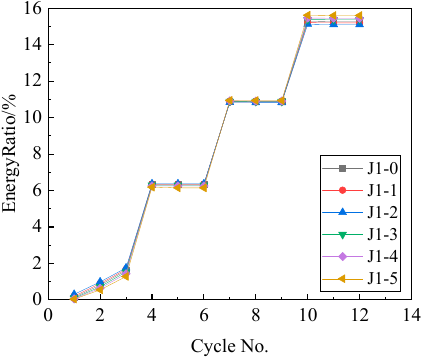
Figure 18. Energy dissipation ratio–cycle no. curves.